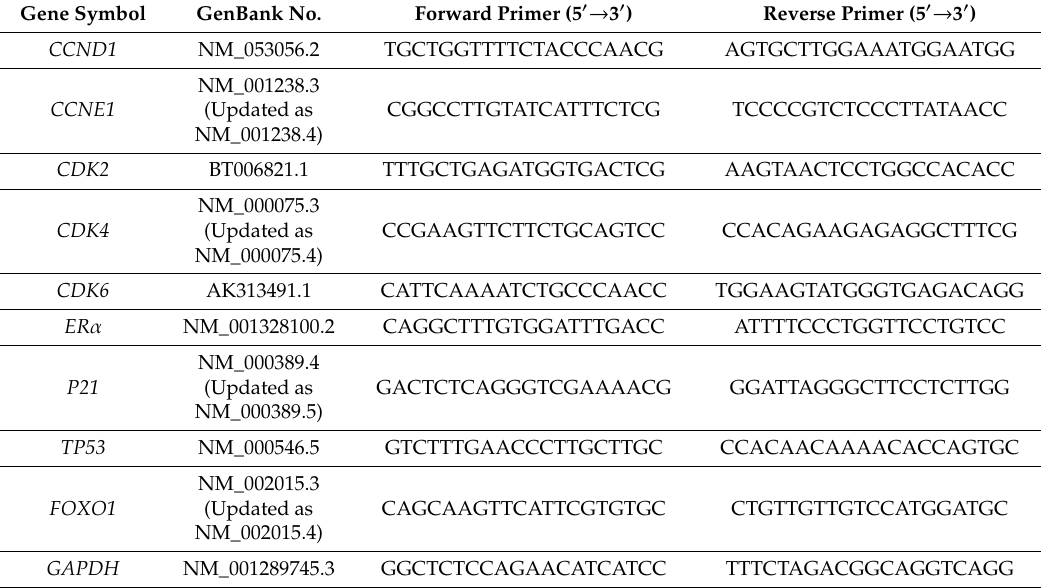
Table 1. Primer sequence for quantitative